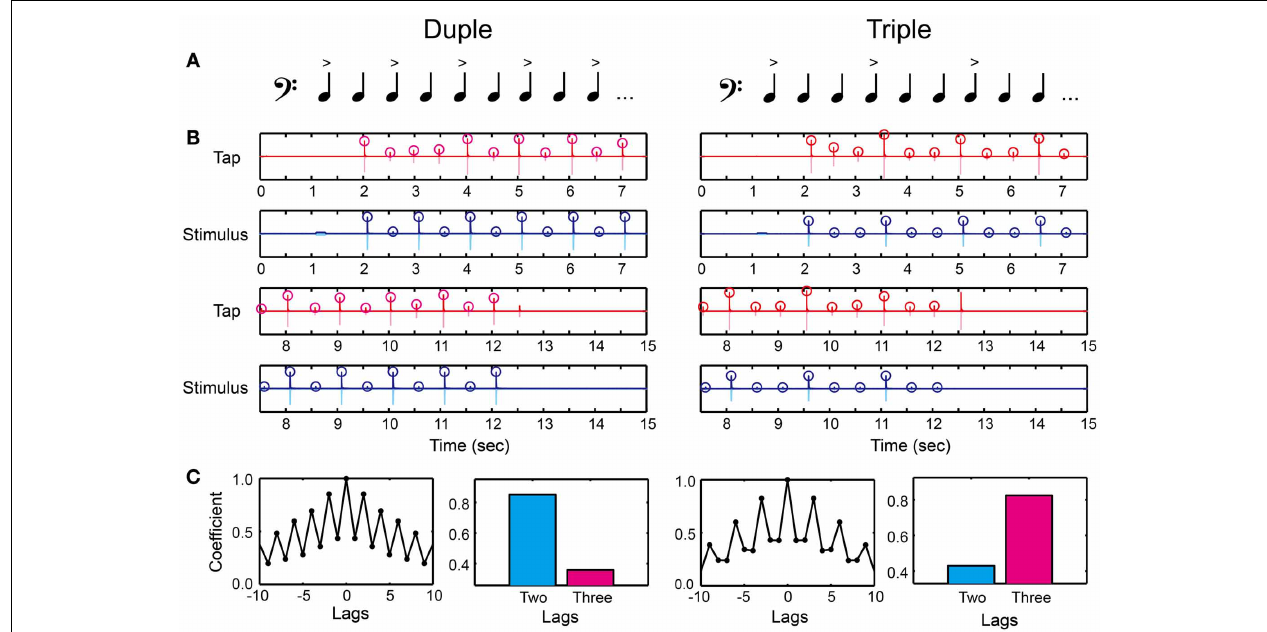
FIGURE 5 | Beat saliency test (BST). (A) Duple or triple meter was created by making accents every two or three tones. (B) An example of recorded tap signal (pink), its envelope (red), recorded auditory stimulus (light blue), and its envelope (blue). Circles represent the detected peak amplitudes. (C)